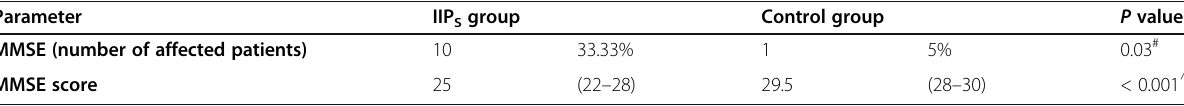
Table 2 Mini Mental State Examination of the studied groups